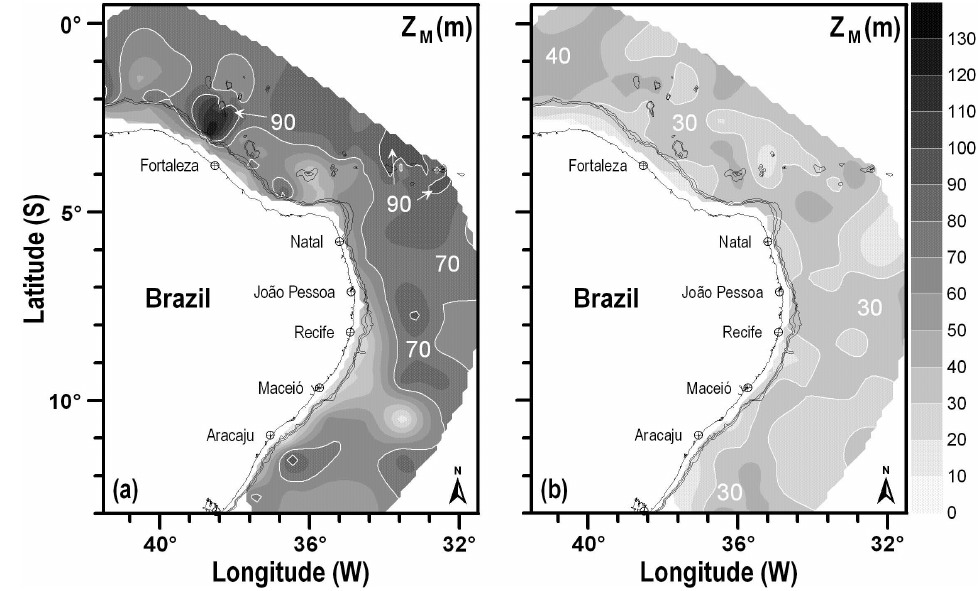
Fig. 5. Spatial distribution of mixed layer depth ( Z M ) during: (a) late austral winter (August–October 1995); and (b) austral summer (January–April 1997).